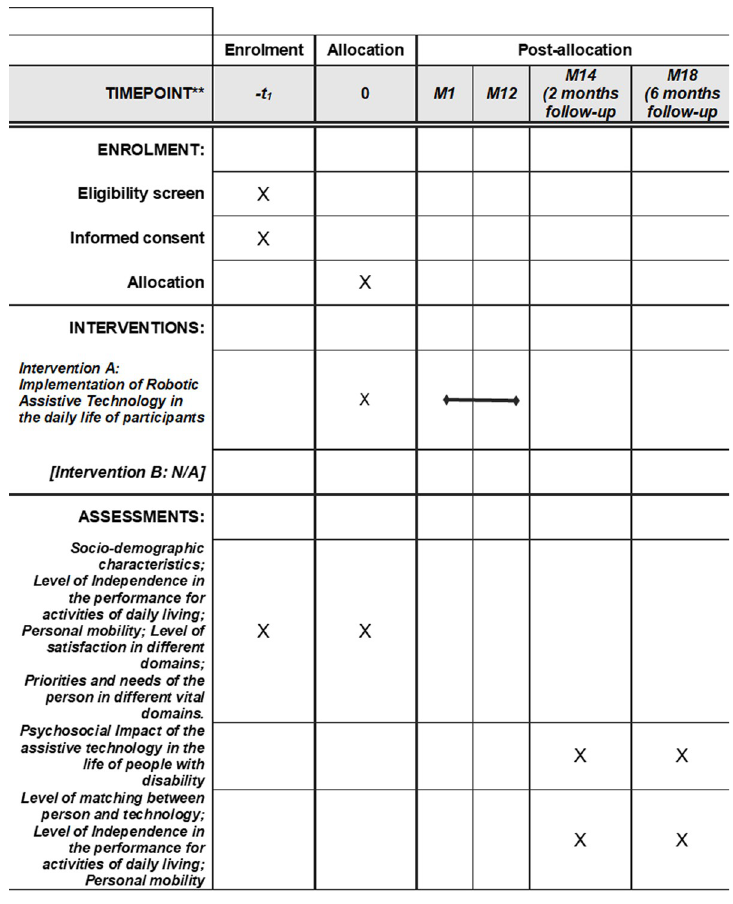
Fig 1. Schedule of enrolment, interventions, and